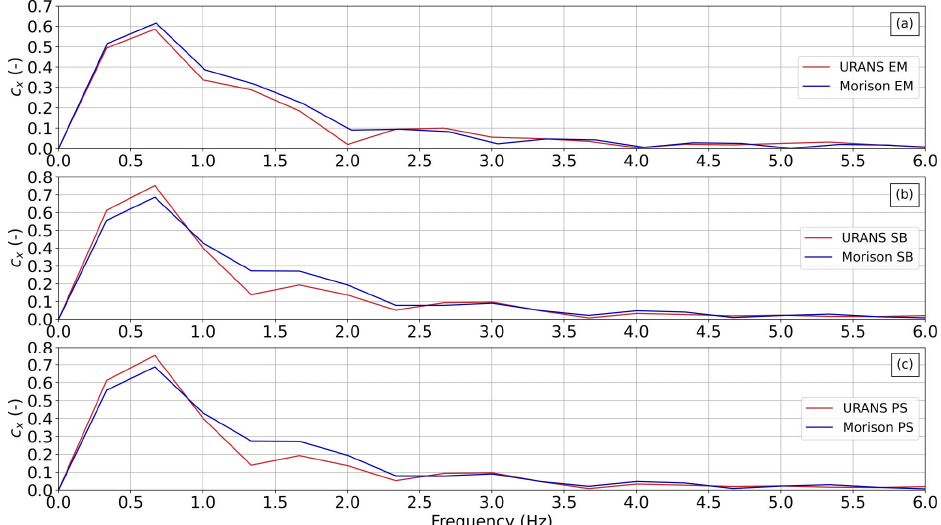
Figure 17. Frequency spectra of load coefficient c x in scenario 2 for the medium ‐ diameter upstream cylinder ( a ), for the medium ‐ diameter downstream starboard cylinder ( b ), and for the medium ‐ diameter downstream portside cylinder ( c ).